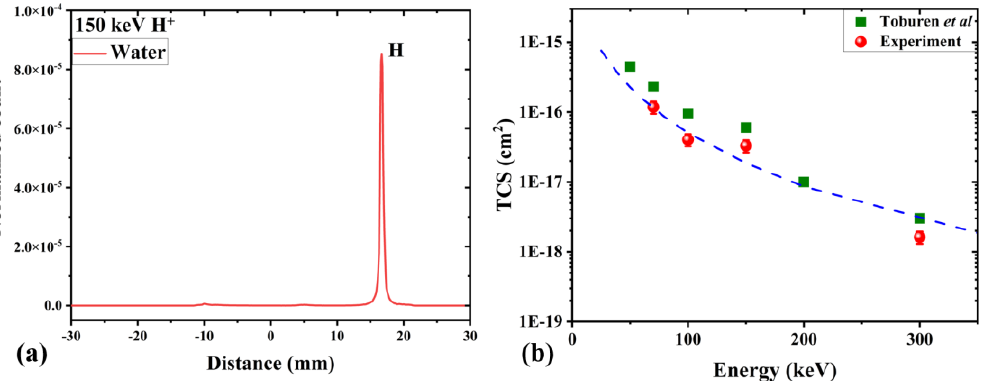
Figure 3. ( a ) Normalized counts for 150 keV H + collisions with water. ( b ) Single e-capture cross section in collisions of H + with water at different beam energies (red circle: present data; green square: Toburen et al. [18]). Dashed lines are guides for the eye. Table 1. The present total cross-section (TCS) data with Toburen et al. [18]. Numerals in brackets indicate the power of 10. The experimental error in the present data is ~20%.